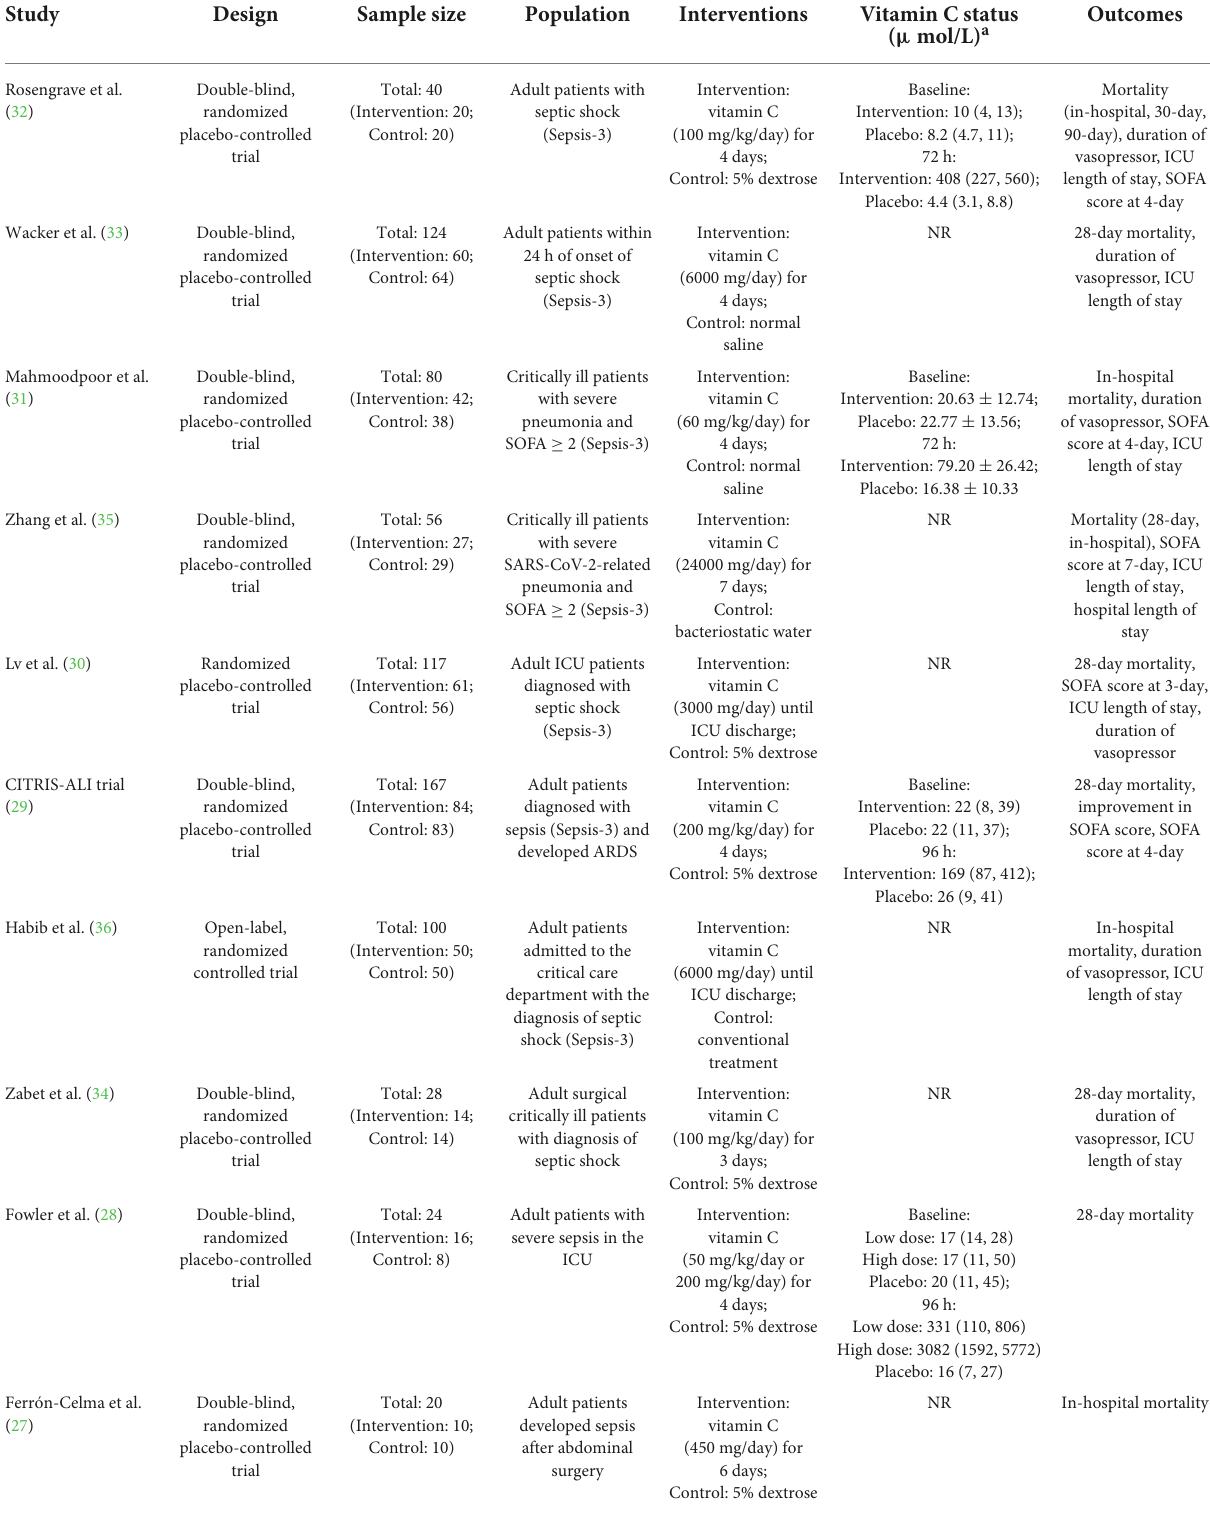
TABLE 1 Characteristics of studies included in the